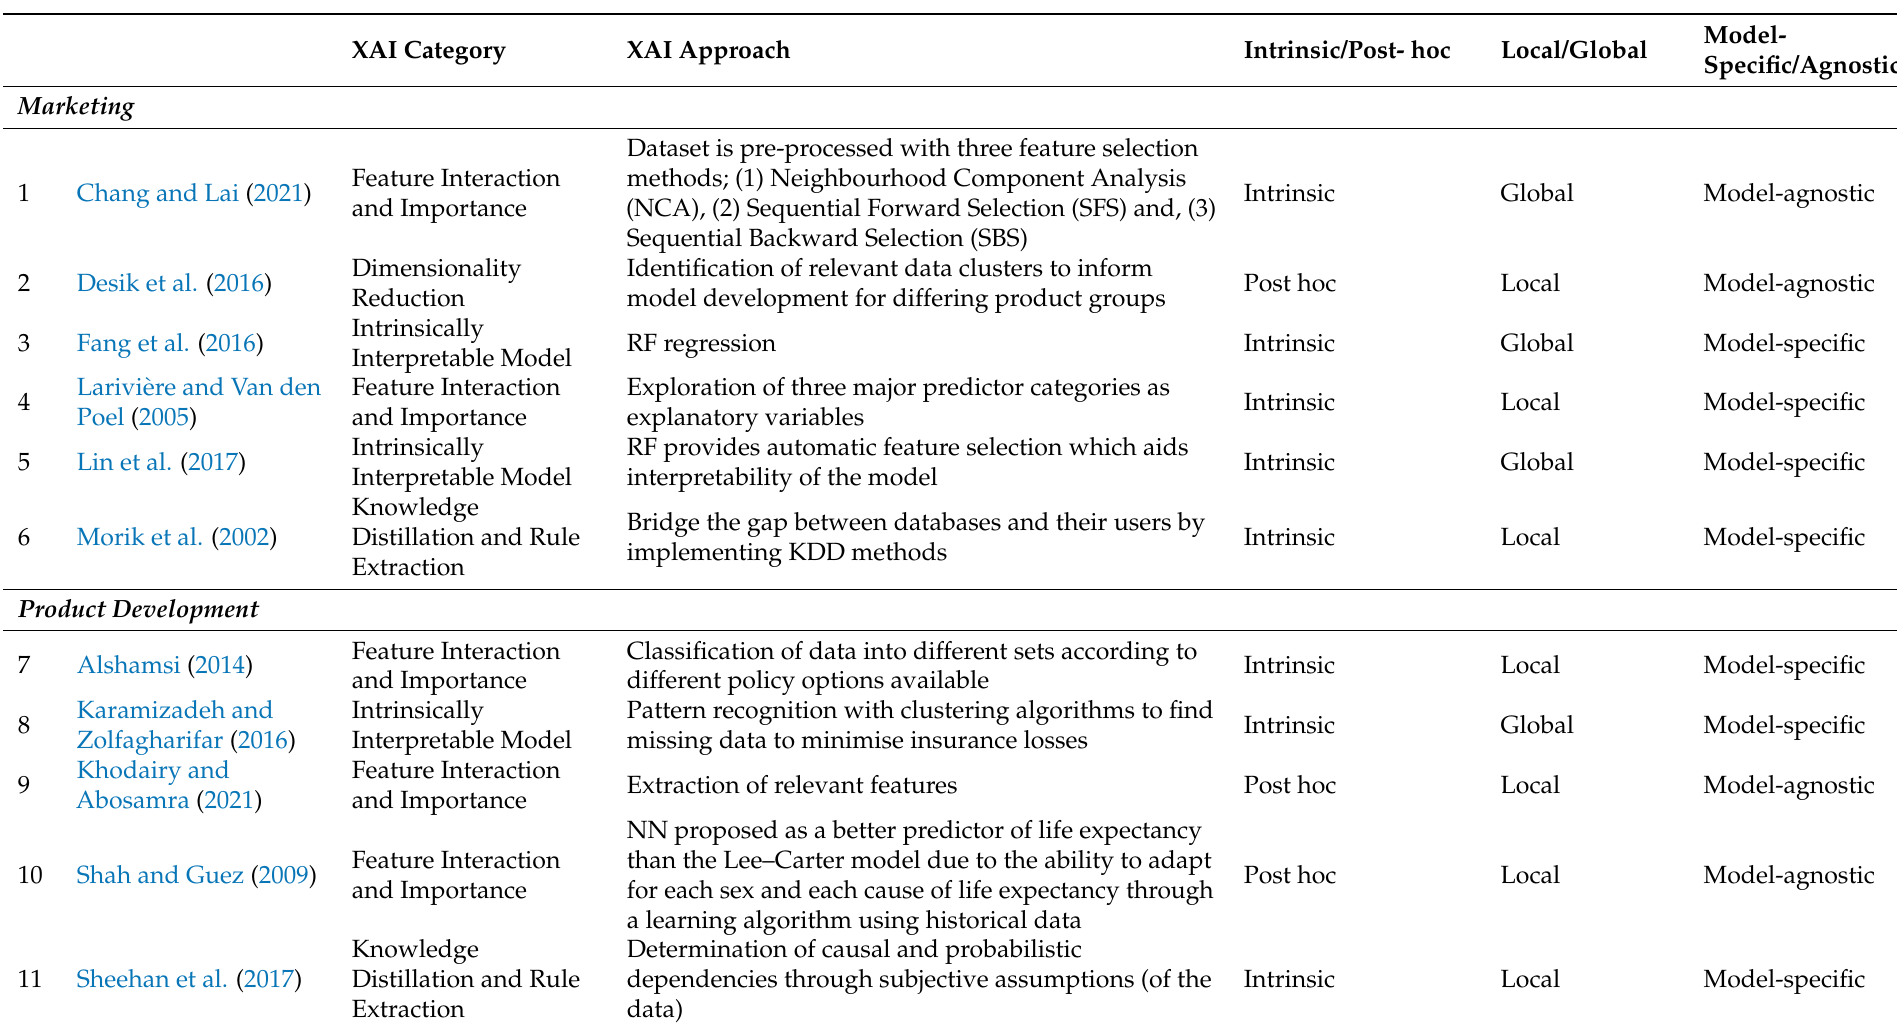
Table 6. XAI Methods and their approach in the articles is outlined, with the additional XAI assessment of (i) intrinsic or post hoc, (ii) local or global, and (iii) model-specific or model-agnostic interpretability methods. Abbreviations in Table 6 are outlined in the Abbreviations section of this